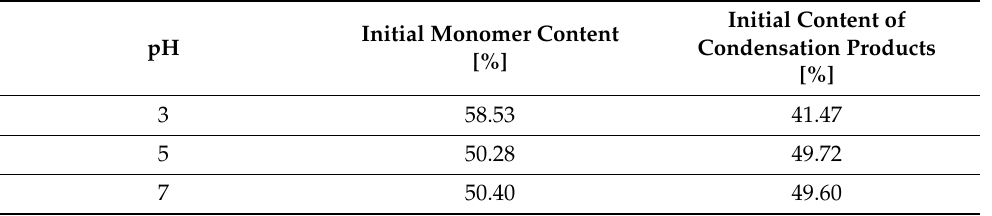
Table 3. Content of monomer and condensation products iron(III) ethylenediamine- N , N (cid:48) -di[(2-